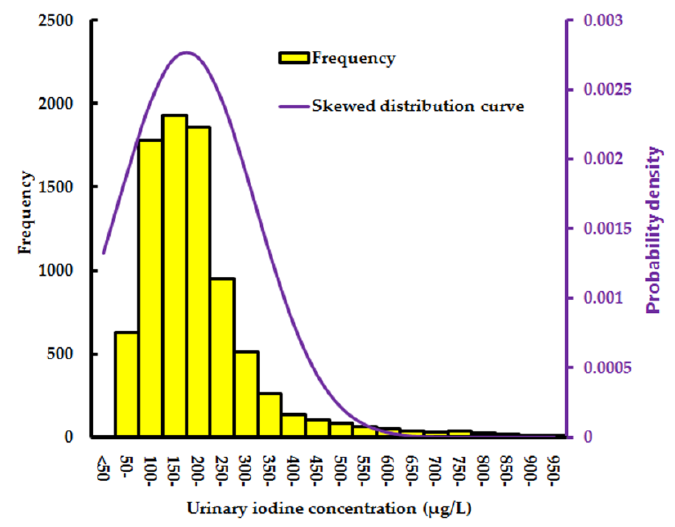
Figure 2. Distribution of UIC in 8510 pregnant women in the Zhejiang province.